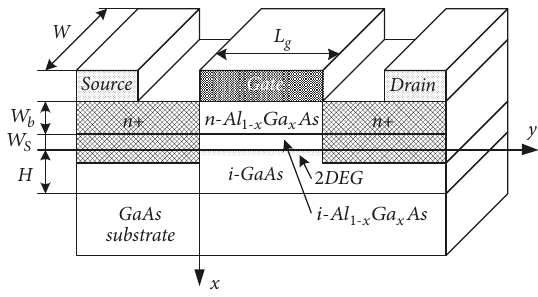
Figure 1: Structure of the AlGaAs/GaAs HEMT